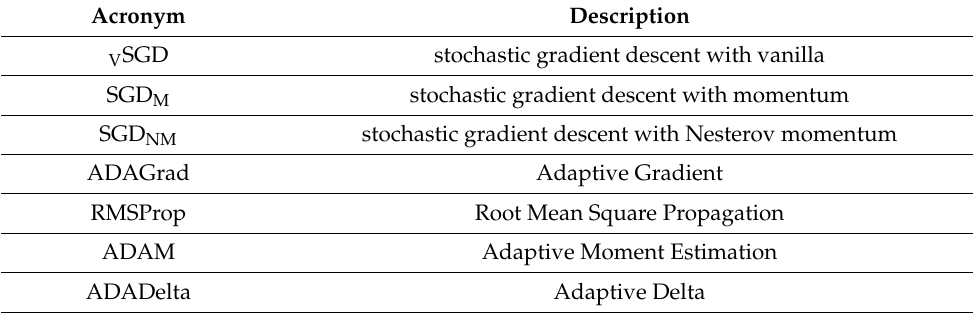
Table A1. List of acronyms adopted in this paper.